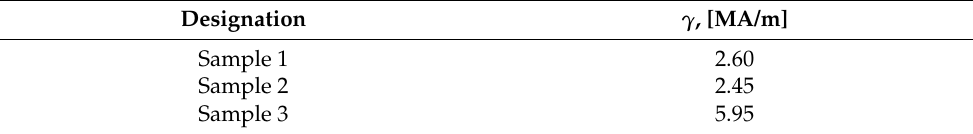
Table 4. The estimated values of 𝛾 and 𝐽 (cid:2929) parameters used to model curves presented in Figure 8.